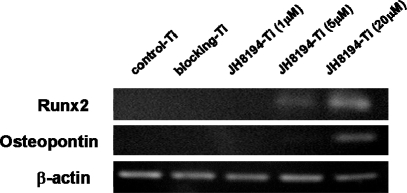
The effects of JH8194-Ti on the osteoblastic differentiation markers were analyzed by RT-PCR. The RNA was extracted from the cells cultured on control-Ti, blocking-Ti and JH8194-Ti for seven days after the cells were seeded. No supplement of soluble JH8194 was added to each well until RNA isolation. Data are representative of three experiments.